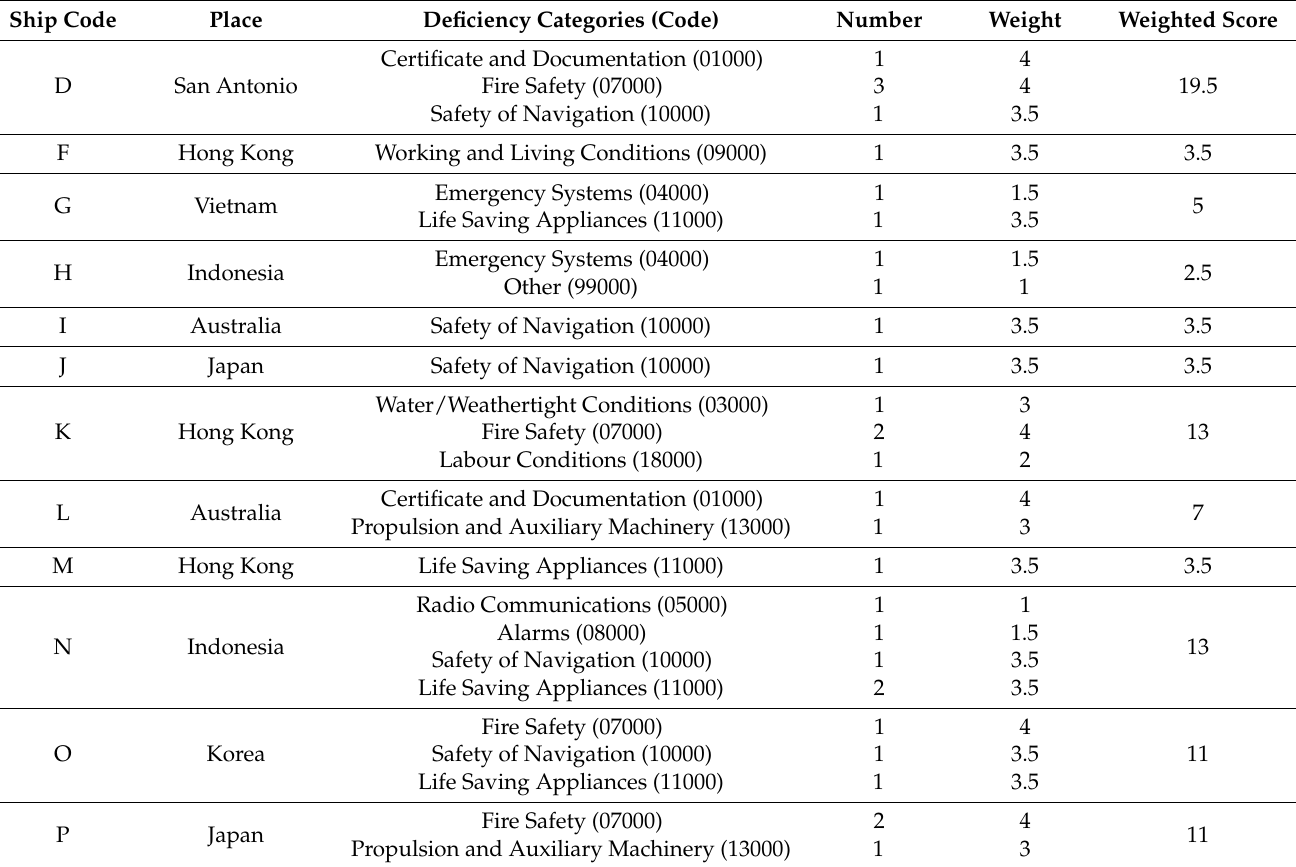
Table 12. Weighted score of ship risk